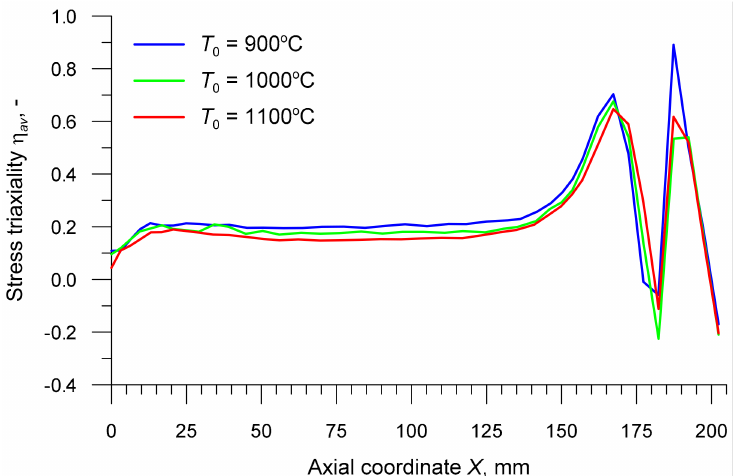
Figure 12. Stress triaxiality in the axial zone of the specimen versus billet temperature T 0